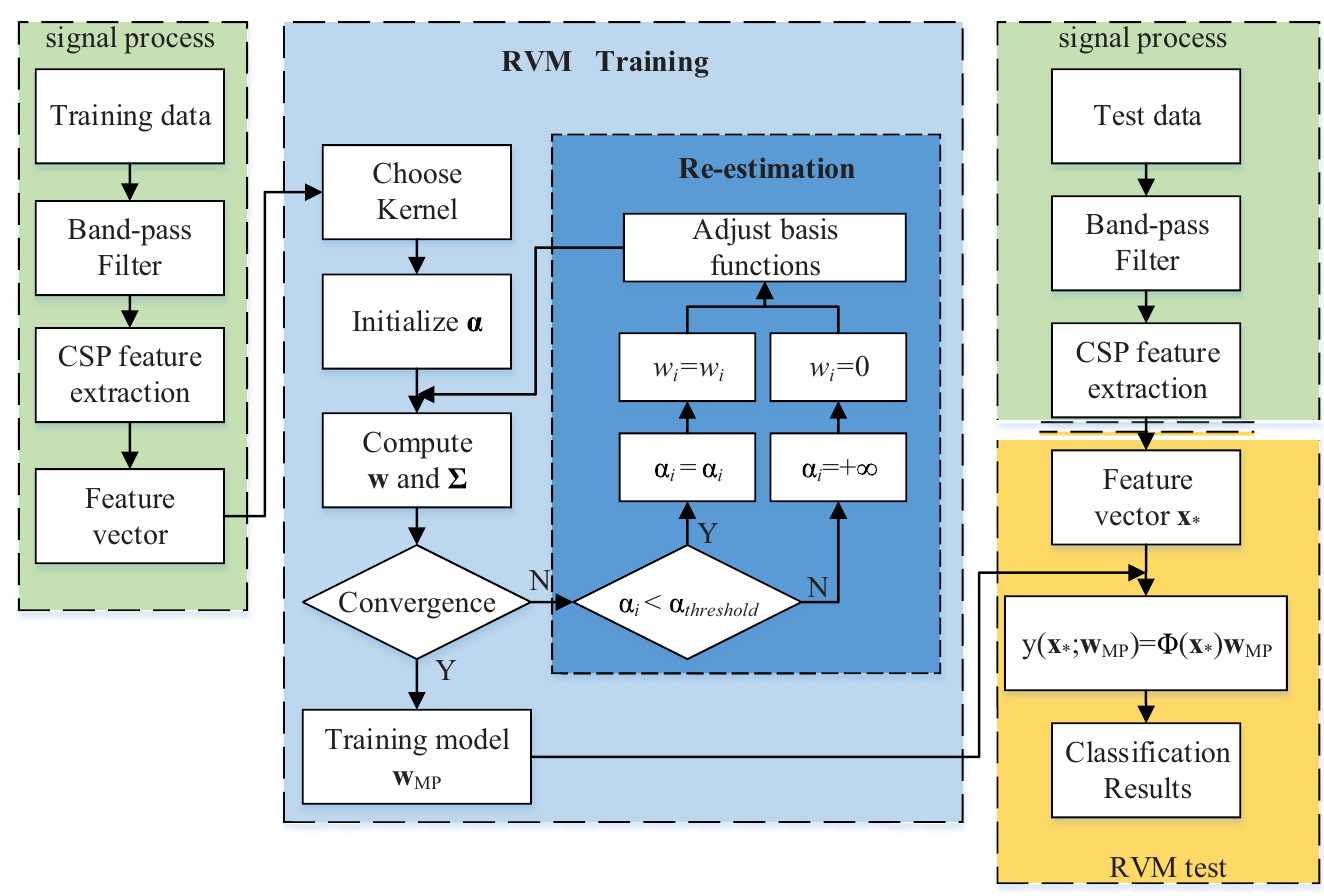
Fig 2. The flow of EEG signal processing and RVM